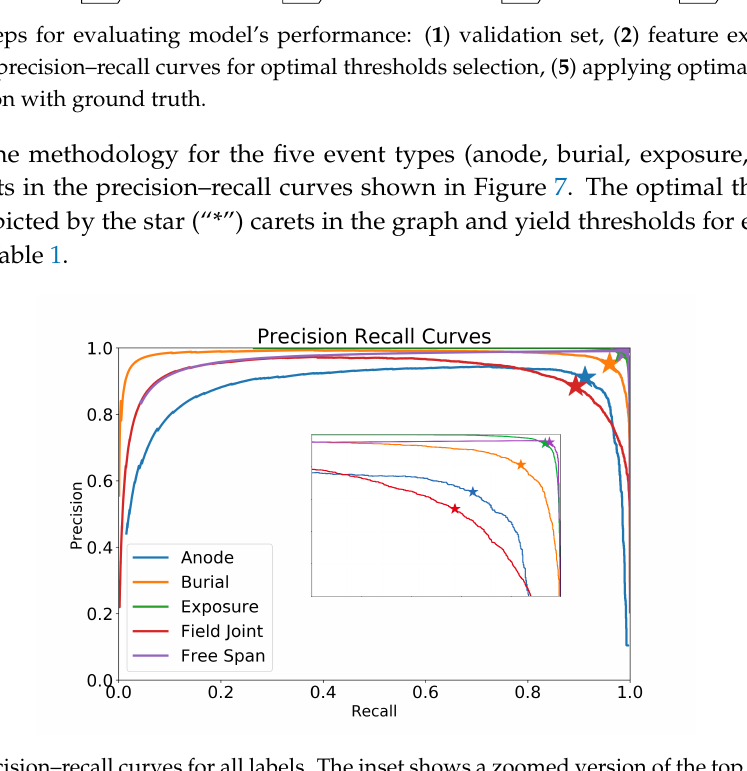
Figure 7. Precision–recall curves for all labels. The inset shows a zoomed version of the top right corner. Table 1. Optimum label-based thresholds for the validation set.